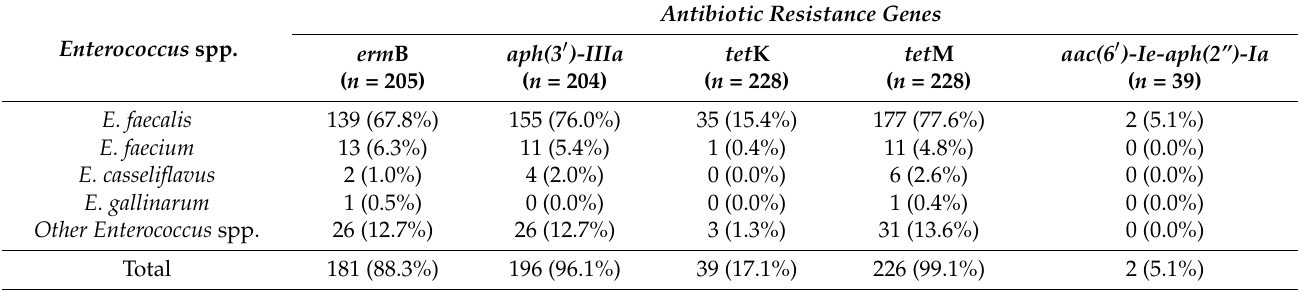
Table 2. Distribution of antibiotic resistance genes in phenotypically resistant Enterococcus spp.